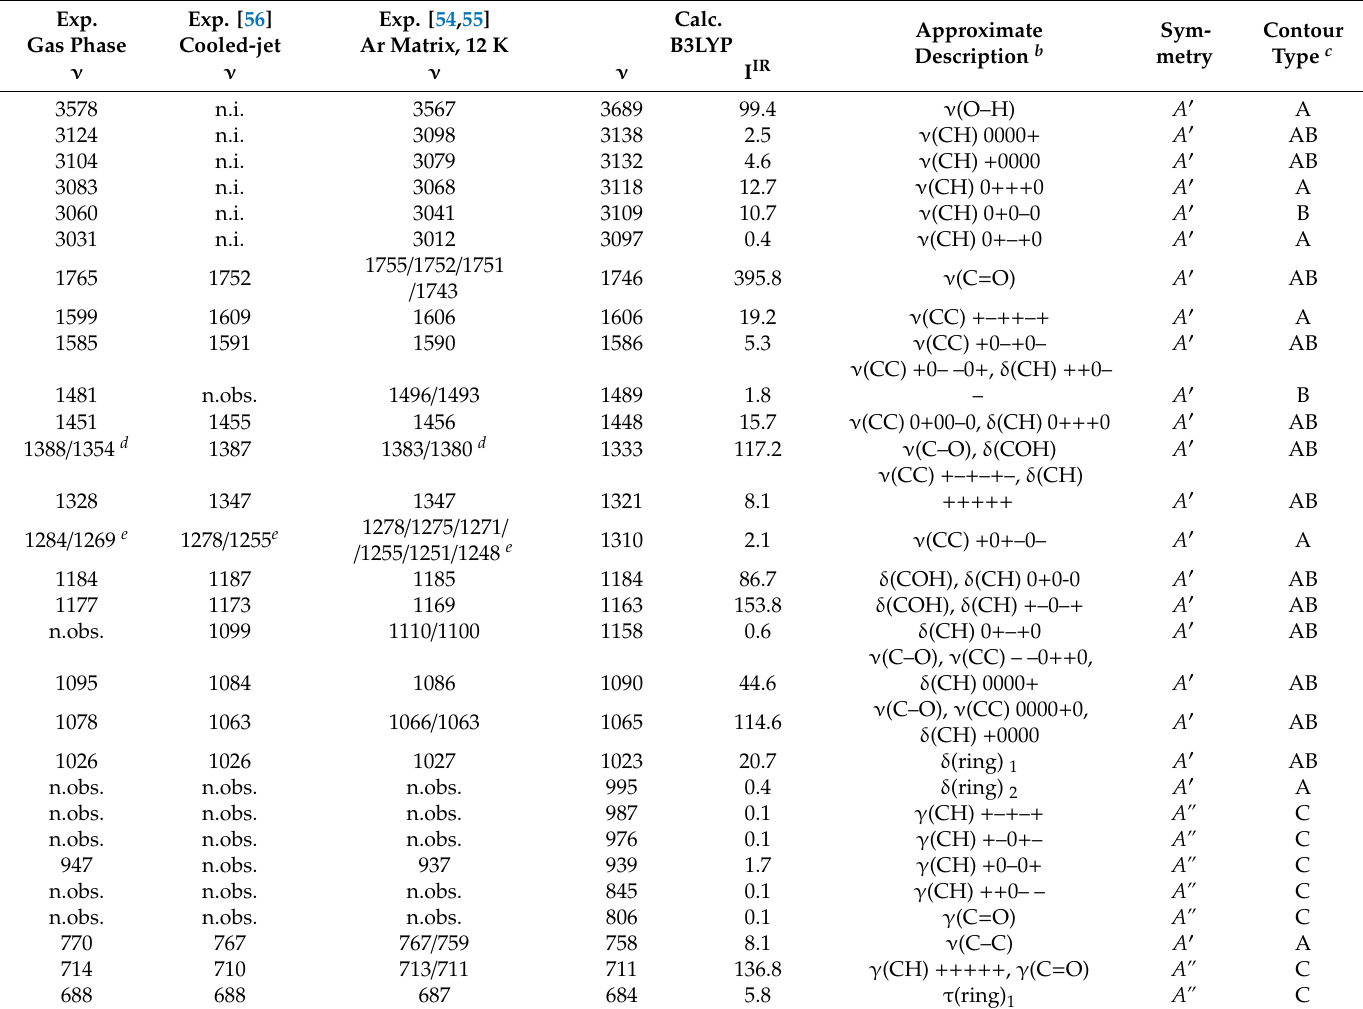
Table 2. Experimental (Exp.) and B3LYP / 6-311 ++ G(d,p) calculated (Calc.) infrared spectra of monomeric benzoic acid, and band assignments a .